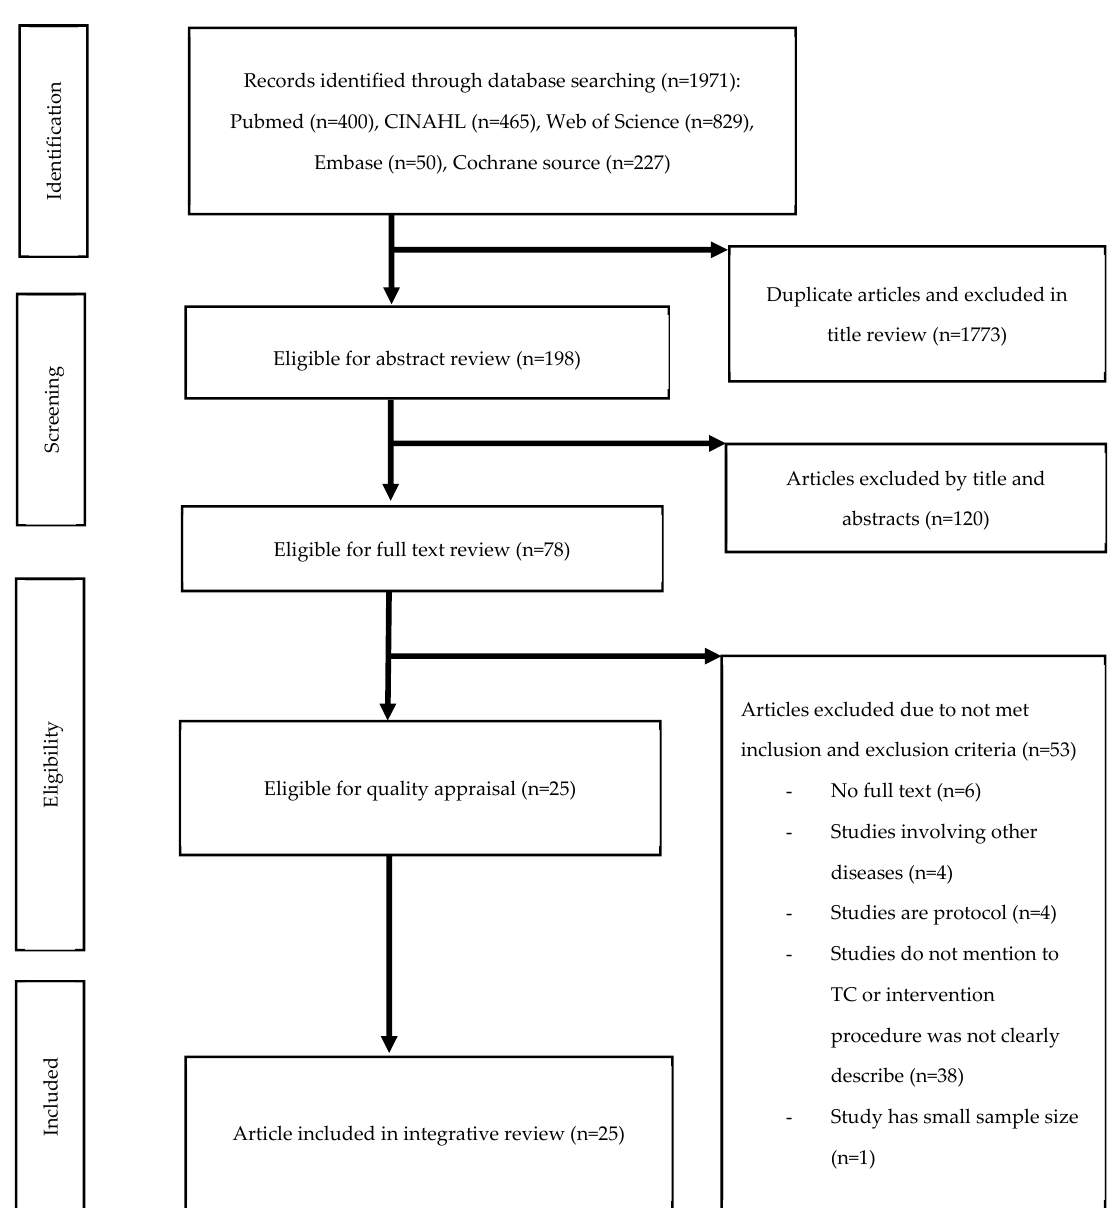
Figure 1. Preferred reporting items for systematic reviews and meta-Analyses (PRISMA) flow diagram outlining the literature search and study selection.